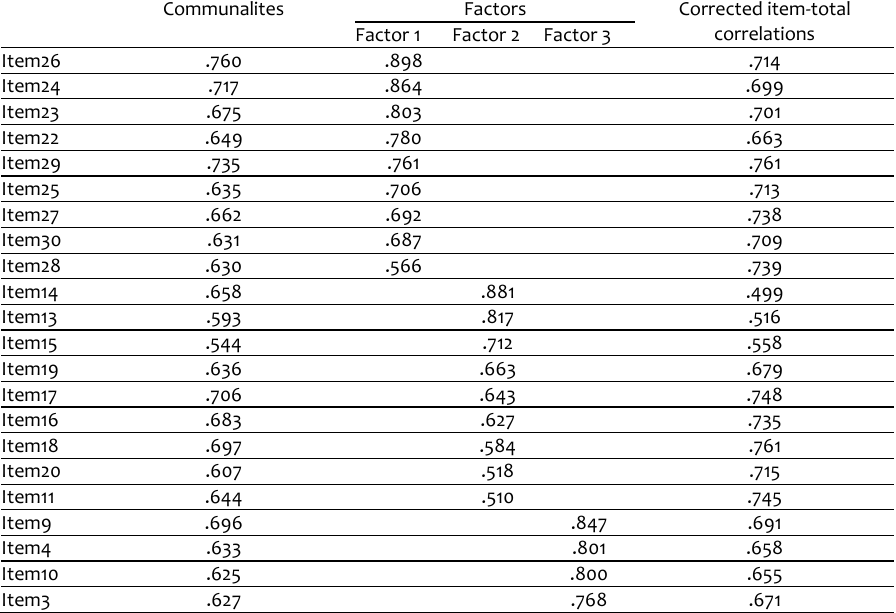
Table 1: EFA results of the scale Communalites